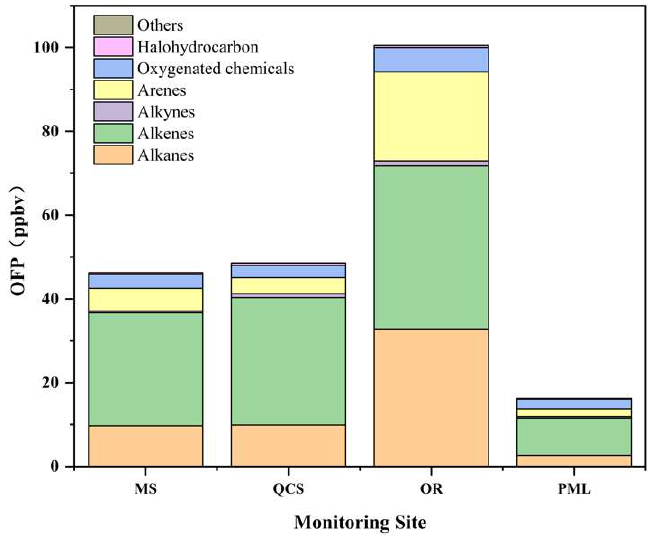
Figure 4. Volume fraction of volatile organic compounds at each site during the observations.